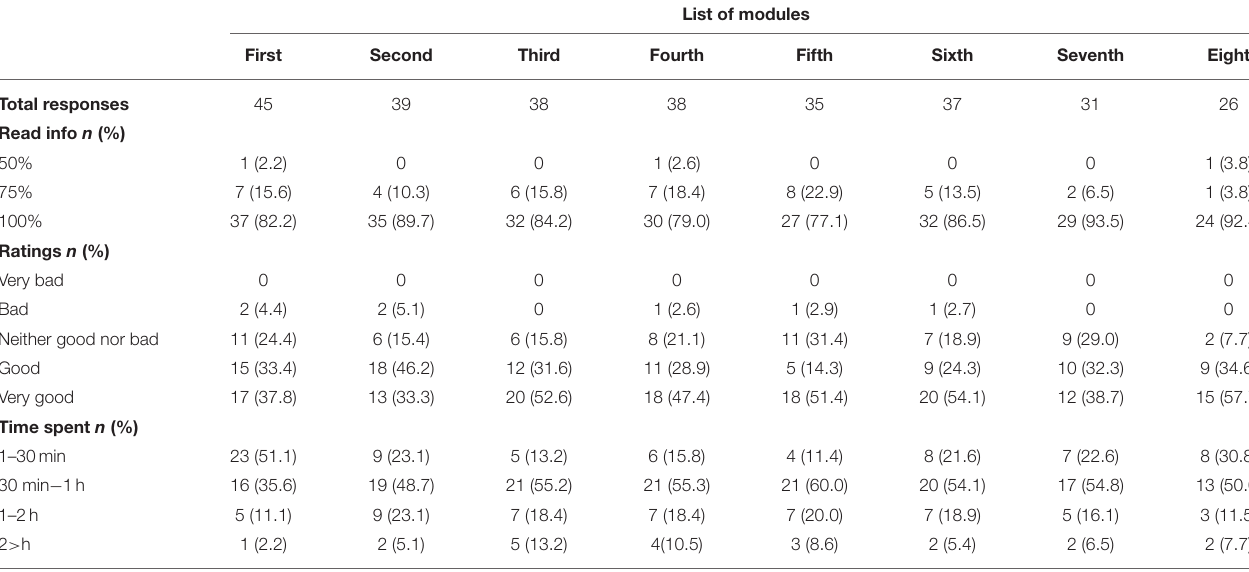
TABLE 2 | Summary of the multiple-choice module evaluation answers from pilot RCT